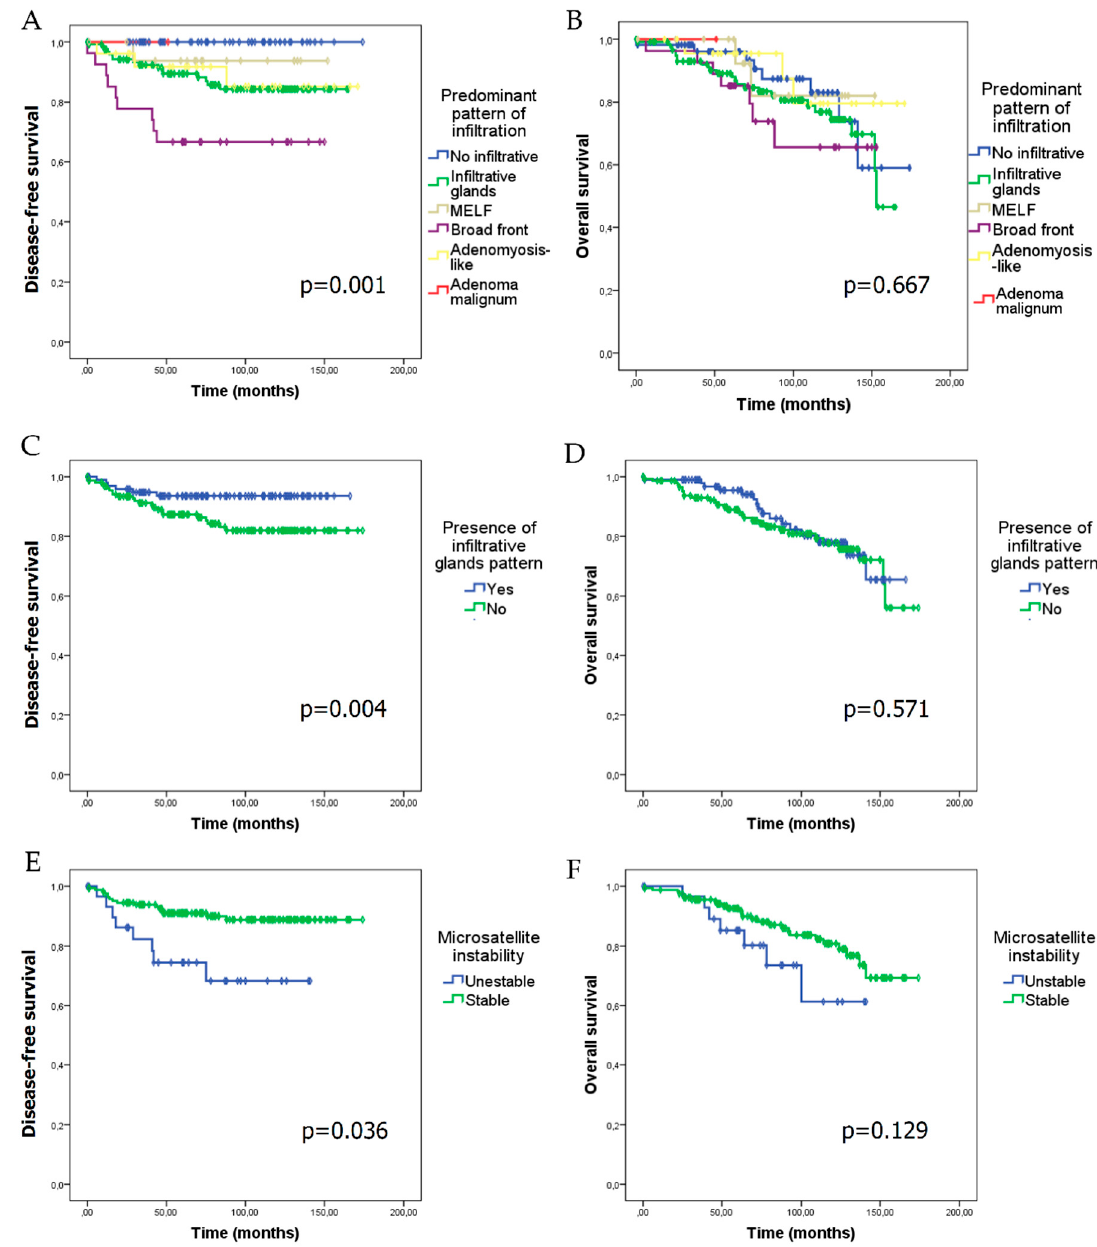
Figure 2. Kaplan–Meier curves for disease-free survival (DFS) and overall survival (OS) according to the predominant pattern of myoinvasion, the presence of infiltrative glands myoinvasive pattern, and microsatellite instability (MSI). DFS ( A ) and OS ( B ) in relation to the predominant myoinvasive pattern. DFS ( C ) and OS ( D ) according to the presence of the infiltrative glands myoinvasive pattern. DFS ( E ) and OS ( F ) in microsatellite unstable versus stable cases.